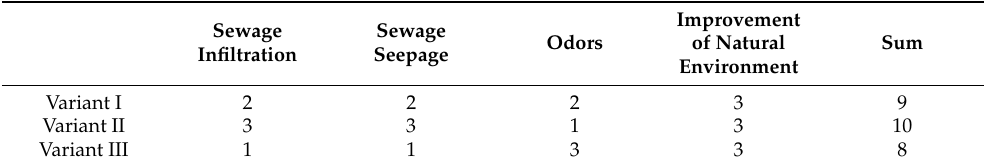
Table 5. Results of centralized sewage management environmental sustainability assessment, 3 points—the best option, 1 point—the weakest option.